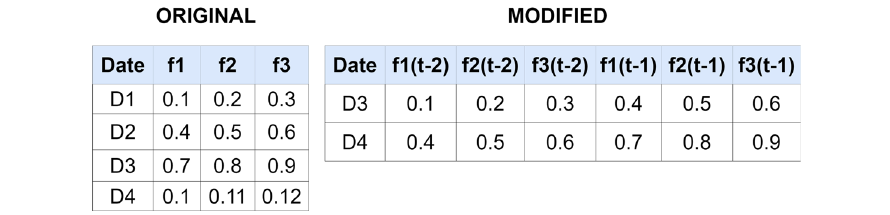
Fig. 4 Dataset with lagging features of